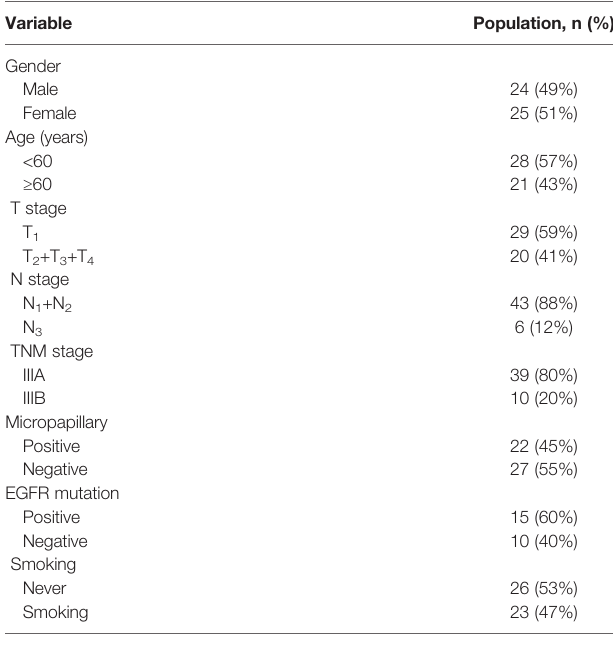
TABLE 1 | Baseline characteristics of patients